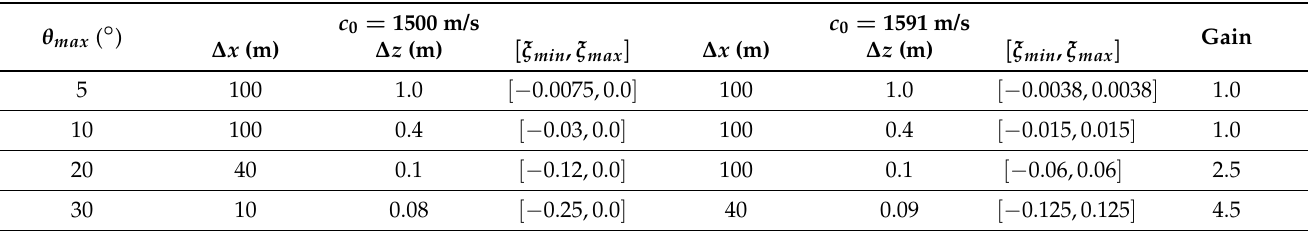
Table 2. Optimal values of the cell sizes, ε = 10 − 3 , x max = 5000 m, f = 500 Hz, rational approximation order is [ 7/8 ] . “ - ” means that a reasonable grid could not be